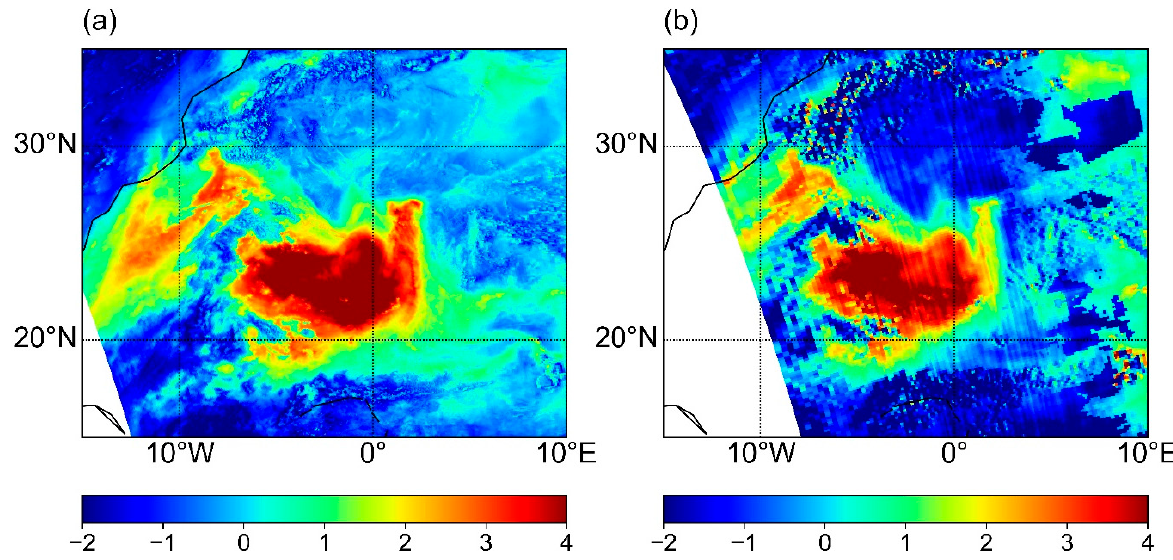
Figure 6. The spatial distribution of AAI results for TROPOMI ( a ) and EMI ( b ) over the Sahara region on 6 August 2019.